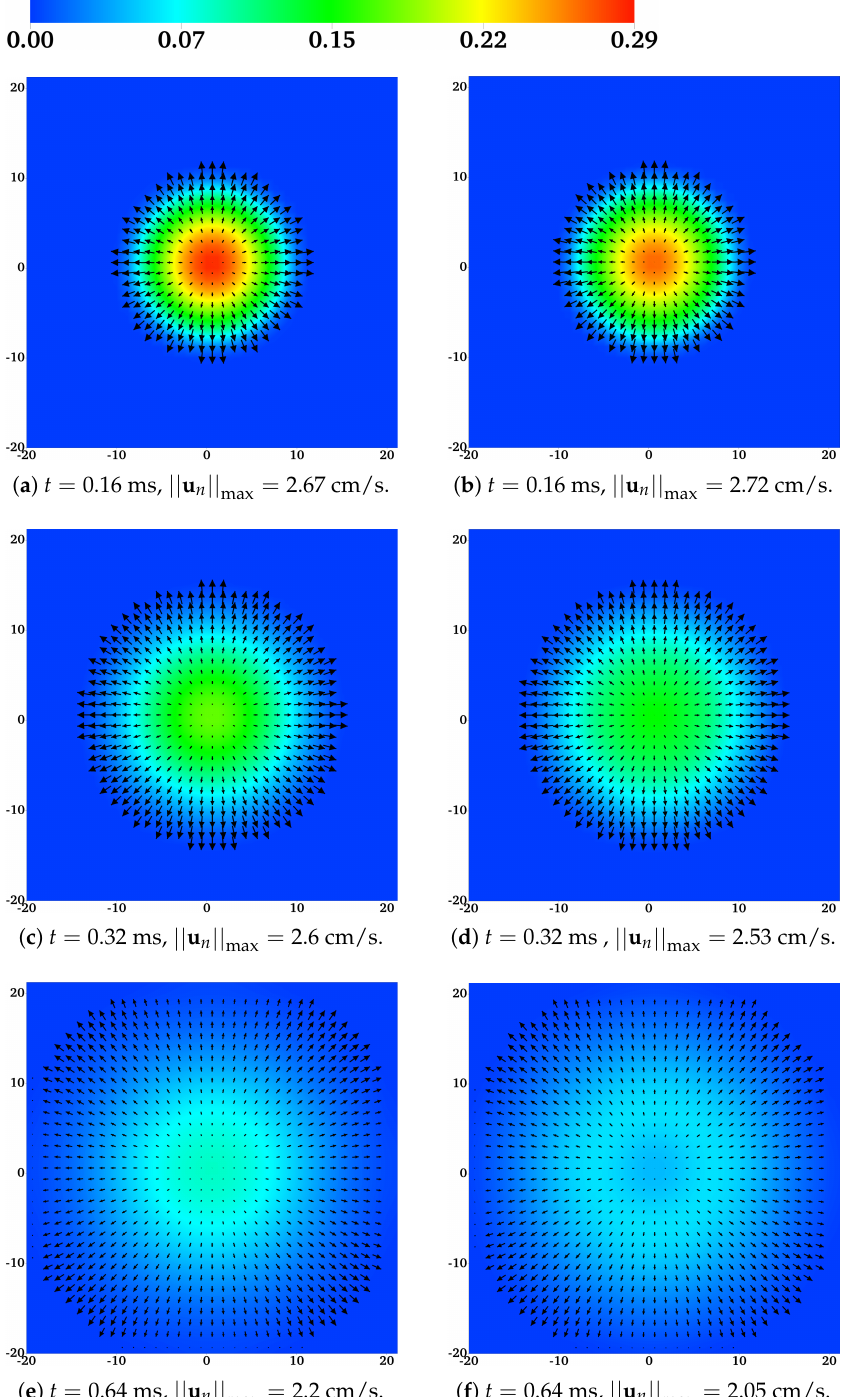
Figure 2. The distribution of the network volume fraction θ n and the network velocity field u n at = 0.001 M and ( b , d , f ) C ∗ = 0.05 M. All vectors have the same different times for ( a , c , e ) C ∗ Na Na